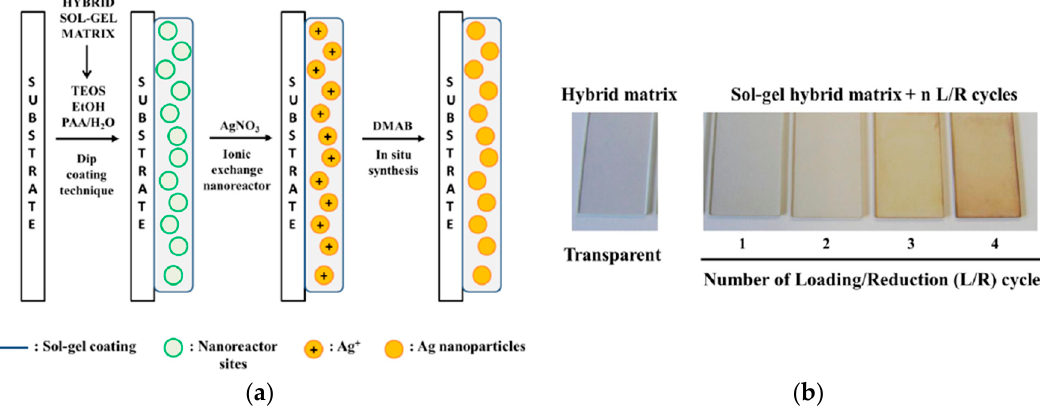
Figure 3. ( a ) Schematic representation for the design of hybrid sol-gel coatings composed of silver nanoparticles (AgNPs) by using a Loading/Reduction chemical process. ( b ) Aspect of the resultant sol-gel hybrid coatings before the synthesis of AgNPs (totally transparent) and after the incorporation of the AgNPs by in situ synthesis process from light yellow to orange coloration. Reproduced from [26] with permission; Copyright Springer